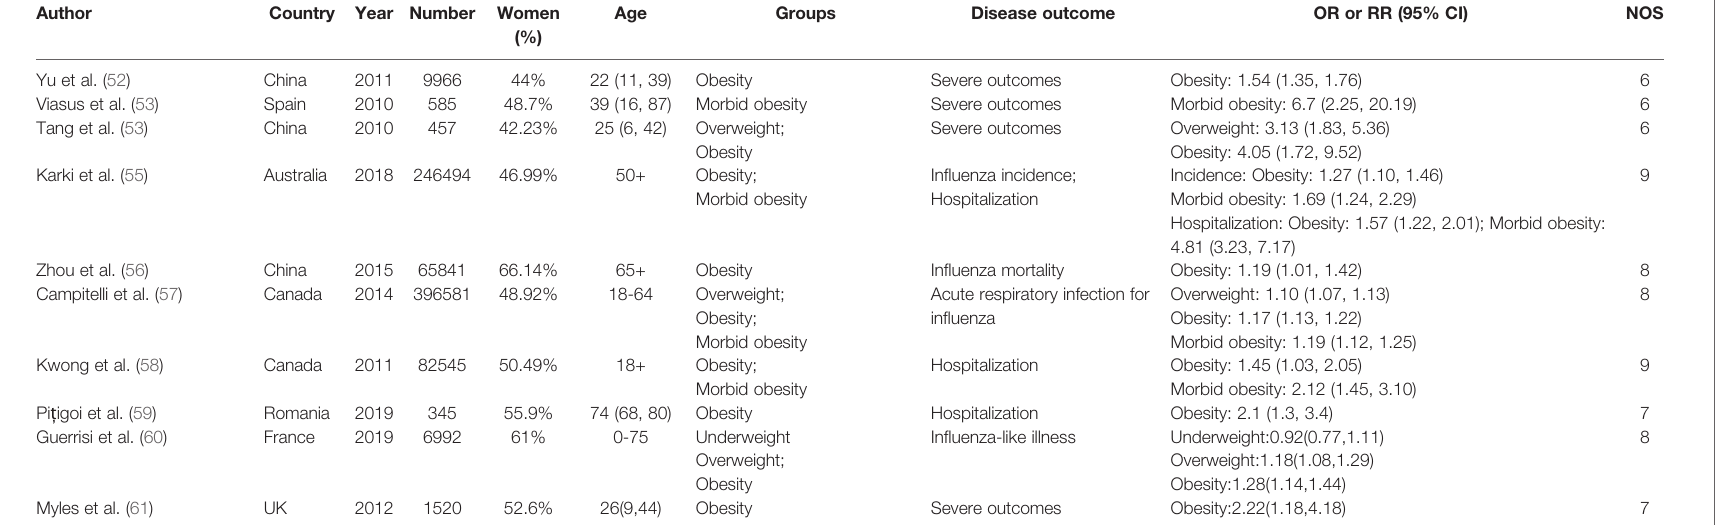
Simonnet et al (11). Cai et al (19). Wu et al (20).